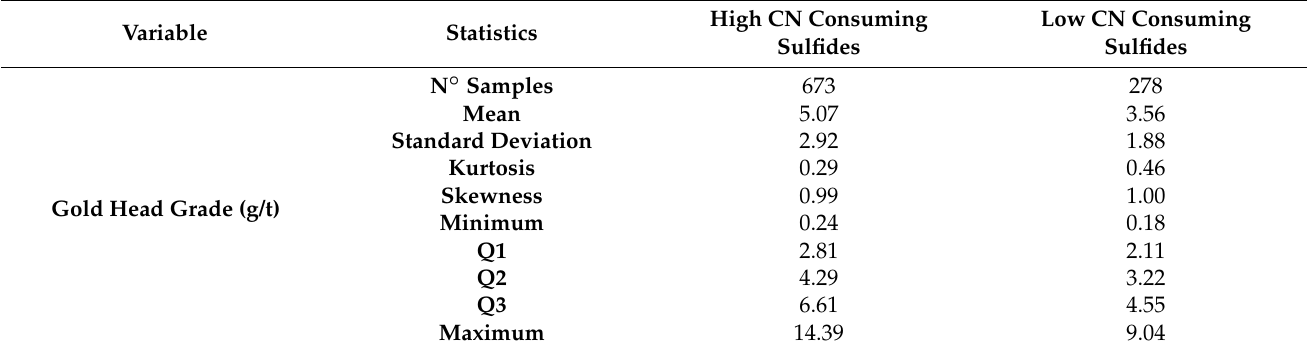
Table 3. Gold head grade statistics by geometallurgical unit.